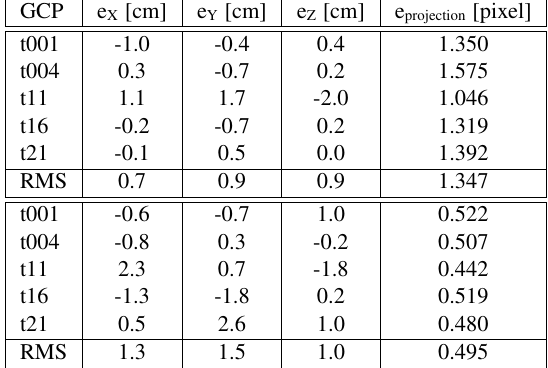
Table 1. GCPs errors summary: Rectangular flight (Top), Circular flight